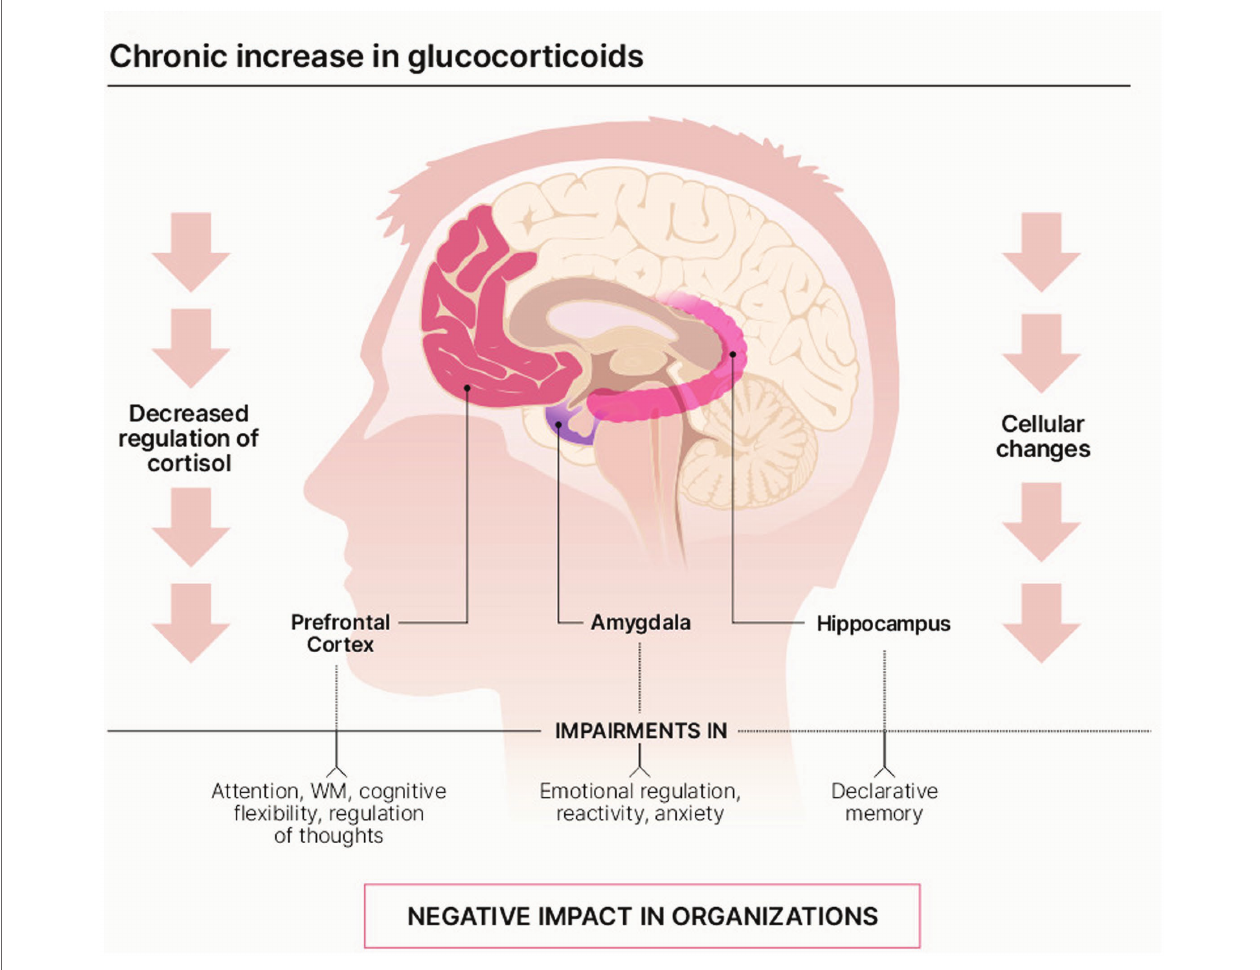
FIGURE 1 | Impact of stress on main brain areas, cognitive functions, and affective